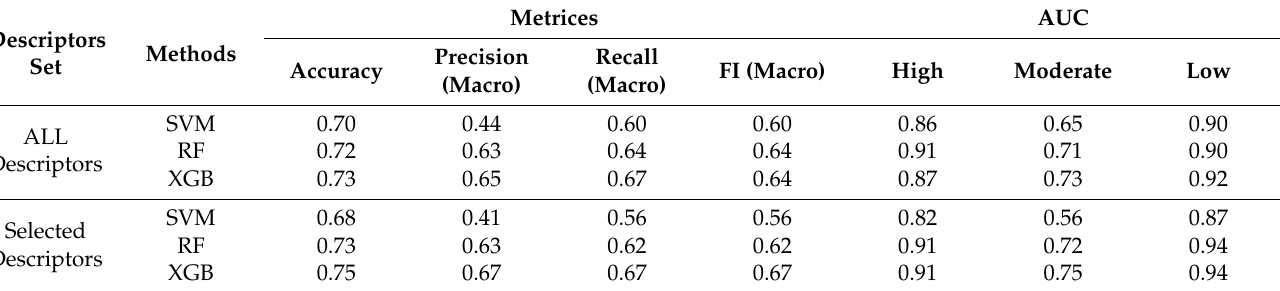
Table 3. Evaluation metrics for multiclass models.